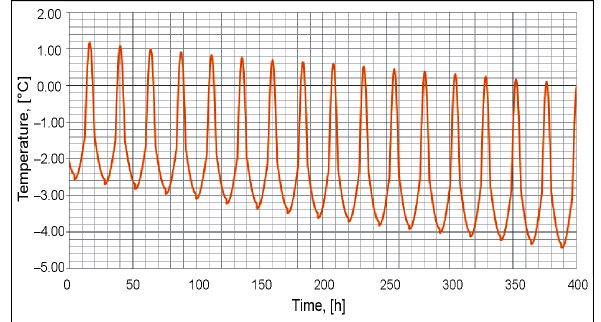
Fig. 1. “Average” outdoor temperature prognosis curve used for building simulation (period from 15th of Decem- ber – 1st of January)